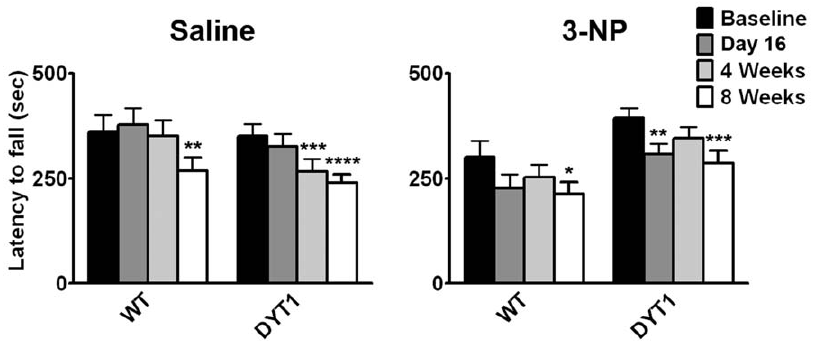
Figure 4. DYT1 genotype does not influence performance in the rotarod after the administration of 3-NP. The latency to fall from the accelerating rotarod was measured 3 times daily for 3 consecutive days at the different time-points indicated. The average value for each time point was used for analysis. Two-way ANOVA for repeated measures showed no interaction between genotype and time point for the saline or 3-NP groups and no effect of genotype. Time influenced performance in both the saline ( F [3,66]=16.72; p , 0.0001) and 3-NP ( F [3,69]=8.81; p , 0.0001) groups. Post-test Bonferroni comparisons to performance at baseline were done (*p , 0.05, **p , 0.01, ***p , 0.001, ****p , 0.0001).